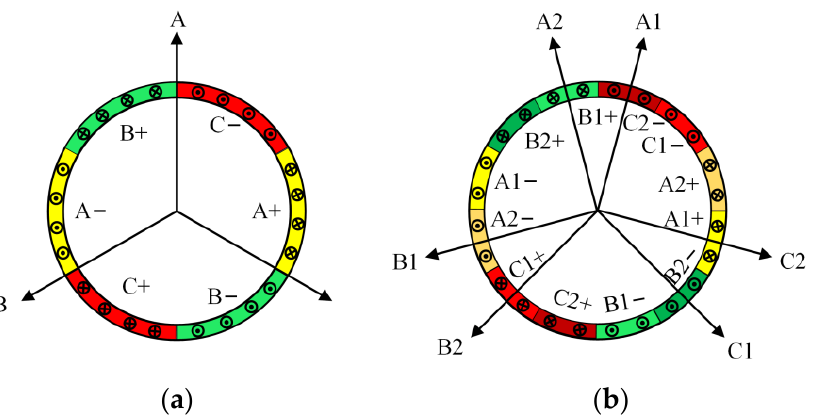
Figure 1. Schematic diagram of different winding structures: ( a ) three-phase winding structure; ( b ) dual three-phase winding structure.